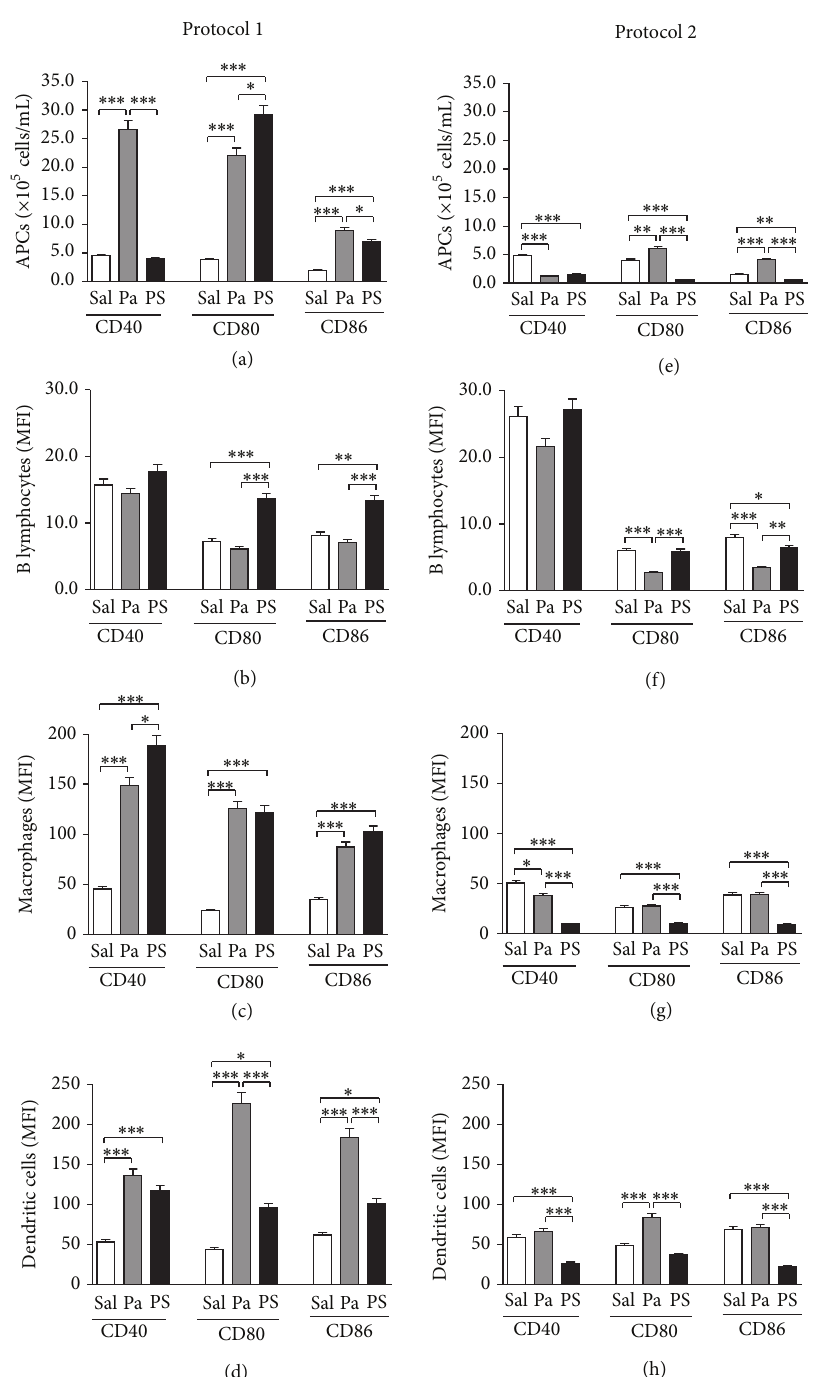
Figure 2: Expression of costimulatory molecules by spleen antigen-presenting cells. Spleen cells from mice treated with saline (Sal), P. acnes (Pa), or PS were obtained 14 days after HEW implantation and stained with fluorochrome-conjugated monoclonal anti-mouse antibodies to determine the expression of CD40, CD80, and CD86 by B lymphocytes, macrophages, and dendritic cells. Percentages obtained by flow cytometric analysis were converted to absolute numbers of B lymphocytes, macrophages, and dendritic cells positive for each molecule, which were added to obtain the total number of spleen APCs positive for such molecule in Protocols 1 (a) and 2 (e). Expression levels were also determined by mean fluorescence intensity (MFI) and individually analyzed in B lymphocytes ((b) and (f)), macrophages ((c) and (g)), and dendritic cells ((d) and (h)) for Protocols 1 and 2, respectively. ∗ 𝑃 < 0.05 ; ∗∗ 𝑃 < 0.01 ; ∗∗∗ 𝑃 < 0.0001